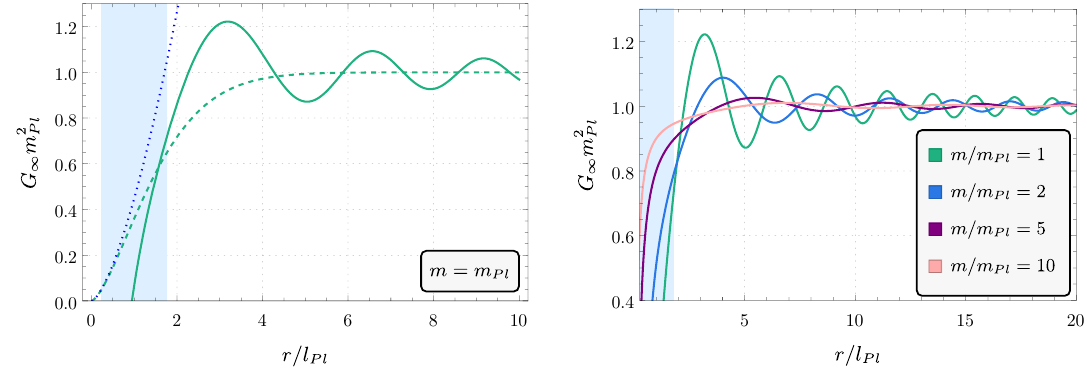
Figure 5 . Effective Newton coupling G ∞ as a function of the radial coordinate in the static limit at the end of the collapse, for ω ≡ 1 . The left panel shows static solutions to eq. (3.27) in different approximations and for m = m . Below the Planck scale, r . l , the effective Newton coupling is Pl Pl approximated by the solution (5.2) to the equations in the fixed point regime, and scales as ∼ r 3 / 2 (dotted line). The solid line displays the analytic solution (5.6) for large radii and is characterized by damped Airy functions of the form (5.9) where we set c 1 /m . The blue region is where the 1 , c 2 ≡ transition between these two analytical solutions (5.2) and (5.6) should occur. Finally, the dashed line shows the exponential function (5.10) which smoothly interpolates between the analytic solution in the UV and the Newton’s constant G = m − 2 in the IR, and solves eq. (3.27) in the static limit 0 pl and in the special case where the amplitude of the oscillations vanishes. The right panel depicts the analytic solution (5.6) with the function F ( r ) specified by eq. (5.9) at large radii for different black hole masses. At a given radius, the amplitudes of the oscillations decrease, whereas their wavelengths increase for growing mass parameter m . All solutions are valid at large radii, and are not expected to provide a good approximation in the blue region where the transition to the scaling solution (5.2)